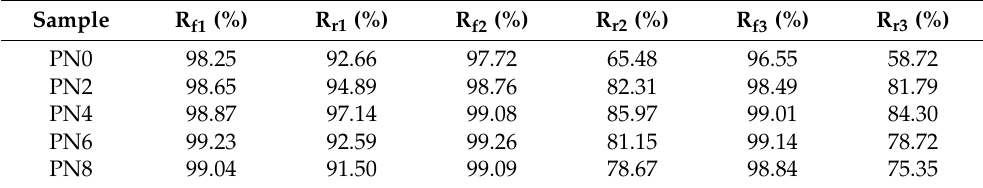
Table 2. R fn and R rn of the PLA/PCL blends with different PCL-NCO